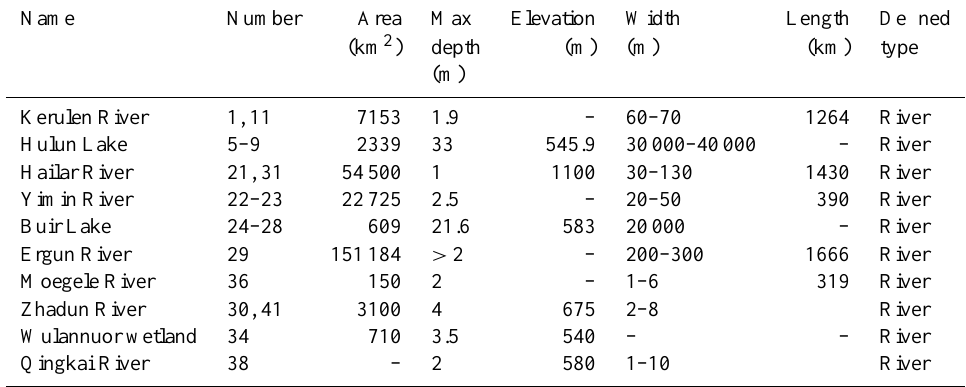
Table 2. Names of rivers (or freshwater lakes), sampling numbers, basin area, width, length, maximum water depth, and elevation in the Inner Mongolia